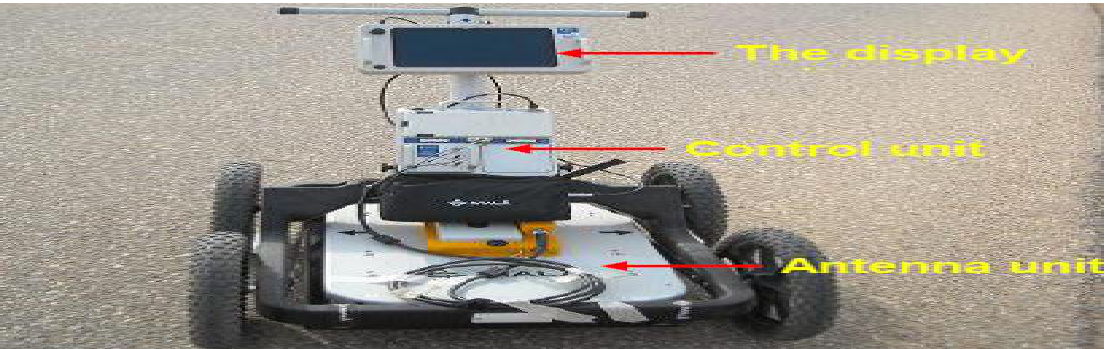
Fig.3: The GPR Device type